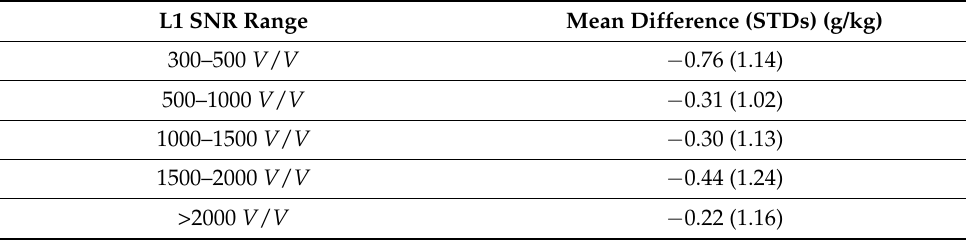
Table 1. Statistics of (RO-RAOB) specific humidity difference from the surface to 12 km altitudes for five SNR groups.